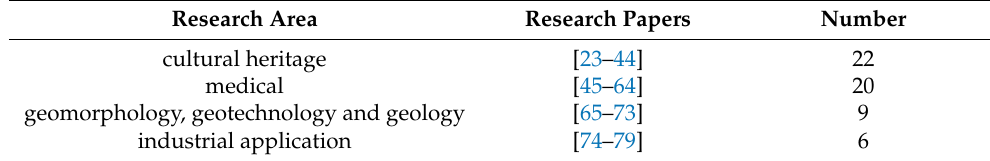
Table 1. Most popular research areas utilizing smartphone photogrammetry within cited